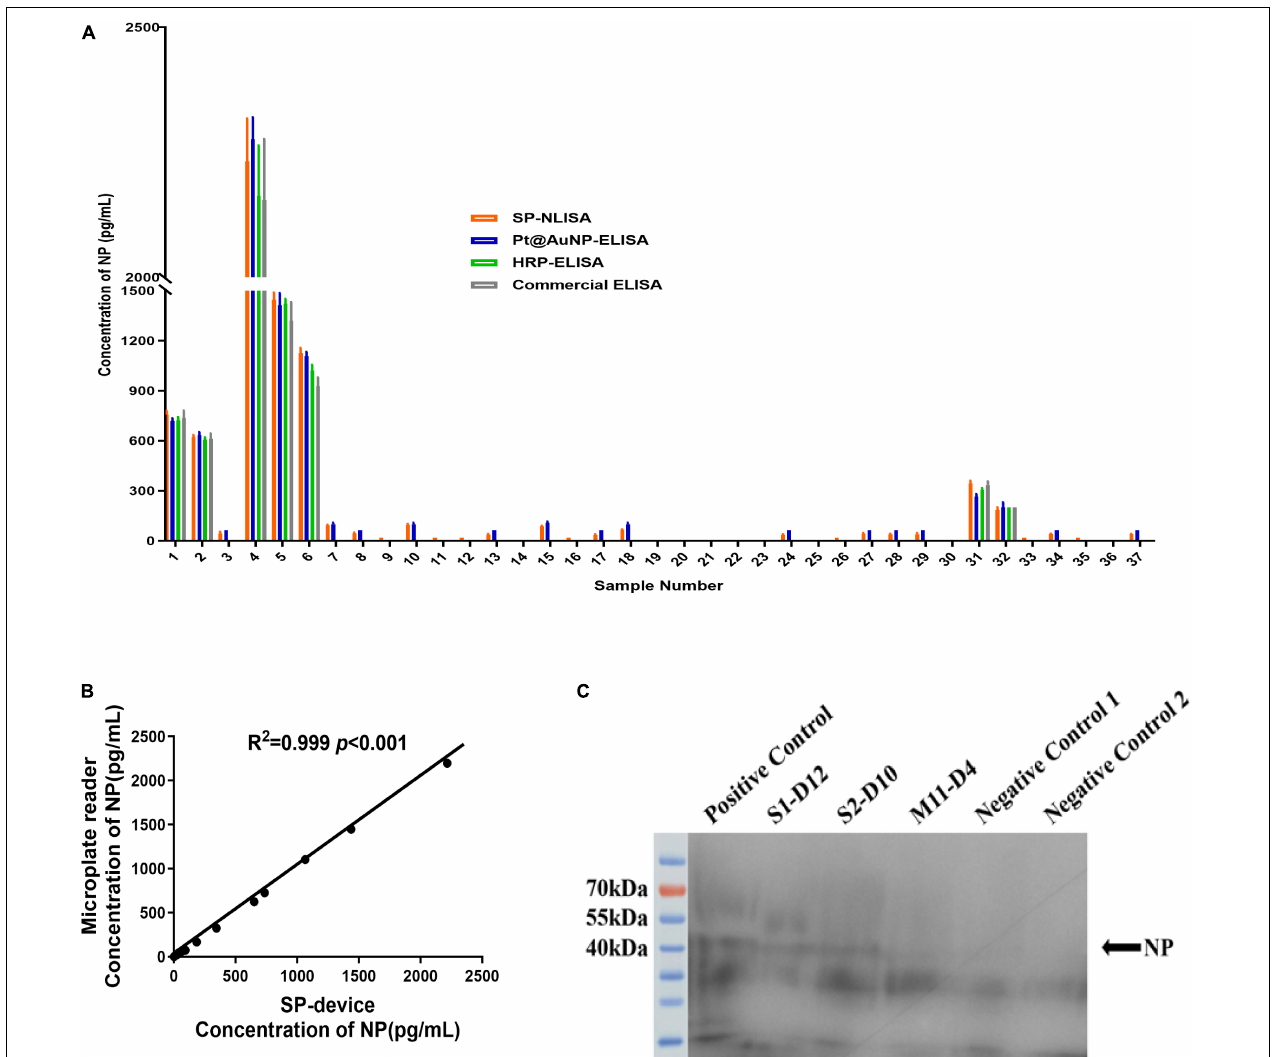
FIGURE 5 | The clinical samples of COVID-19 patients were tested by SP-NLISA. (A) 37 clinical serum samples from 4 severe and 16 mild COVID-19 patients were tested for NP antigen of SARS-CoV-2 by SP-NLISA. The result was represented as a mean of triplicate for each sample. (B) Correlation between SP-device and commercial microplate reader was analyzed by SPSS 18.0, which exhibited an excellent correlation and no significant difference ( R 2 = 0.999, P < 0.001). (C) Identification of NP antigen in serum samples by Western blot. S1-D12, S2-D10, M11-D4 were COVID-19 patients’ samples collected at day 12, 10, or 4 post symptom onset. Positive control was a negative control sample with the addition of 1 µ g/mL NP standard. Negative control 1 was the S4-D27 sample, while negative control 2 was a blood donor sample obtained from the Guangzhou blood center before the COVID-19